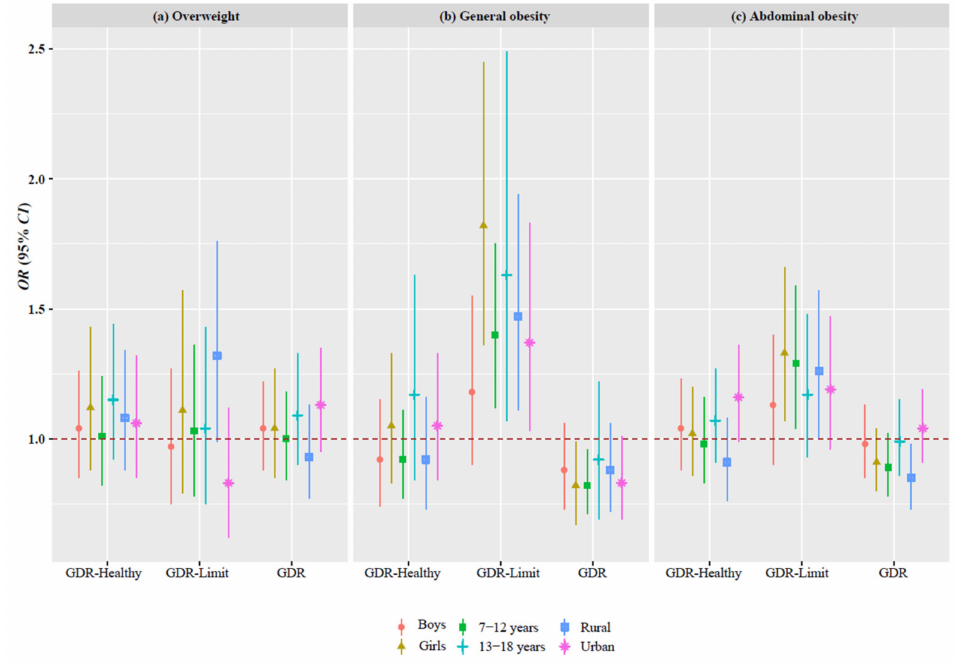
Figure 5. Associations of the Global Dietary Recommendations scores with overweight and obesity by sex, age, and residence. Note: CI, confidence interval; GDR, global dietary recommendations; OR, odds ratio. Logistic regression analyses were used to calculate the odds ratios and 95% confidence intervals with adjustment for sex, age, residence, and urbanicity